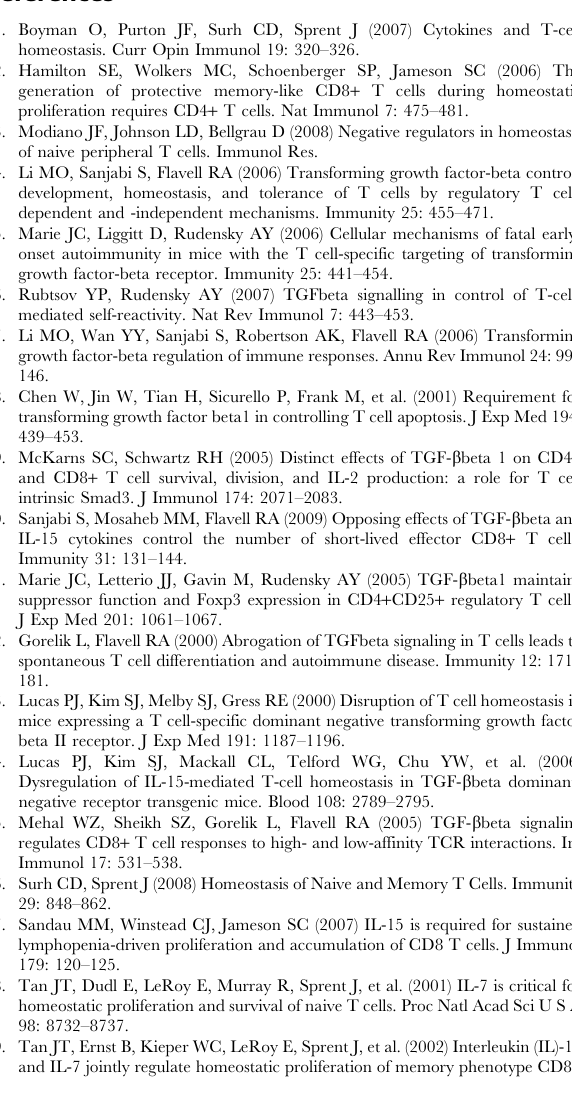
Figure S3 Endogenous CD8 + T cell recovery in sub- lethally irradiated wild type mice. Recovery of CD8 T cells was evaluated 2, 3, and 4 weeks after irradiation and transfer of